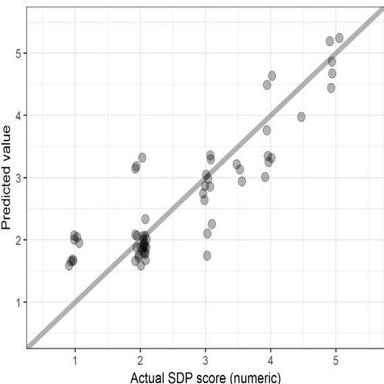
Predicted versus actual SDP scores for the for three-variable model (numeric SDP ~ IACount þ GravWS40 þ IACount.sq); the actual SDP scores are jittered horizontally by up to 0.1 to separate them for more clarity.